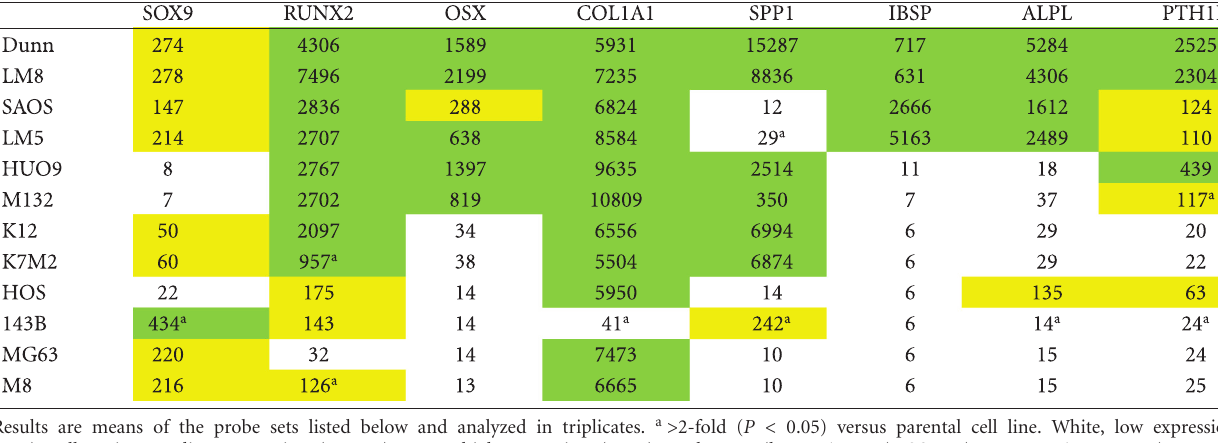
Table 3: Microarray mRNA expression levels of osteoblastic marker